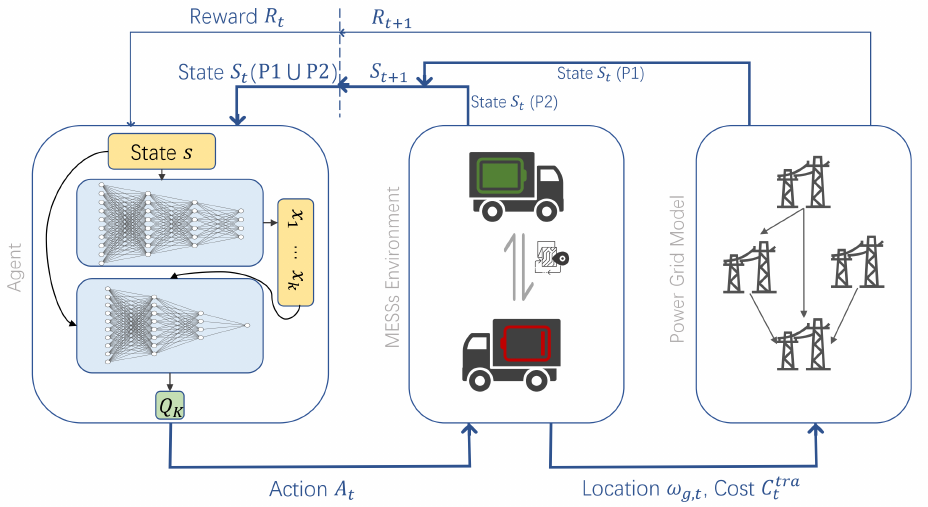
Figure 1. Framework of optimization method for the joint model of MESSs and power